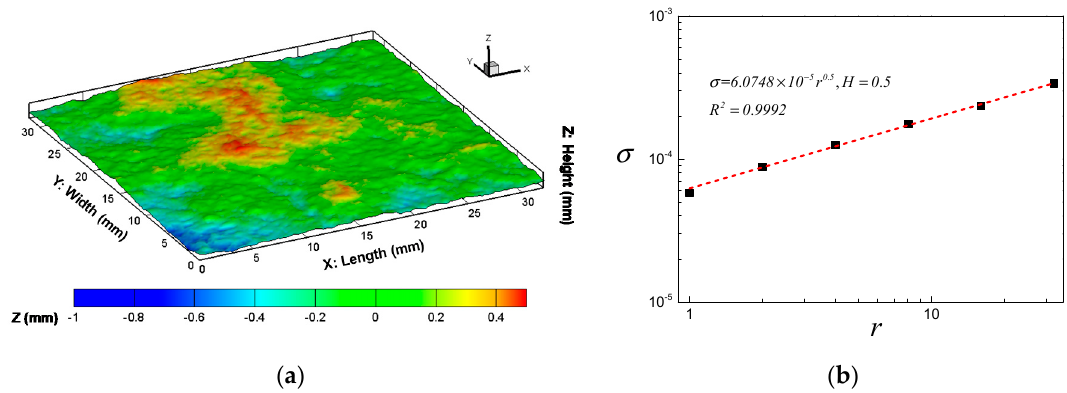
Figure 1. ( a ) Example of self-affine surfaces generated using the modified successive random addition (SRA) algorithm with Hurst ( H ) = 0.50; ( b ) Log–log plot of the standard deviation σ (mm) versus the lag constant ( r , mm).